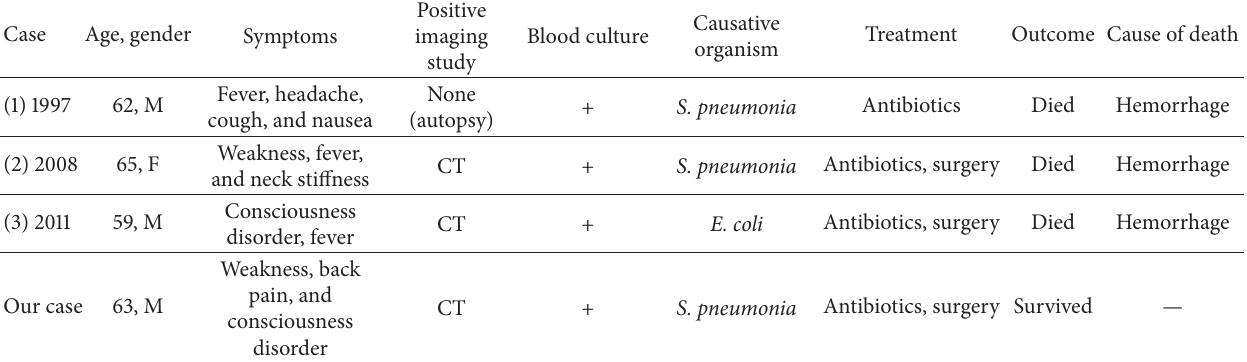
Table 2: Reported cases of infectious abdominal aortic aneurysm with onset from